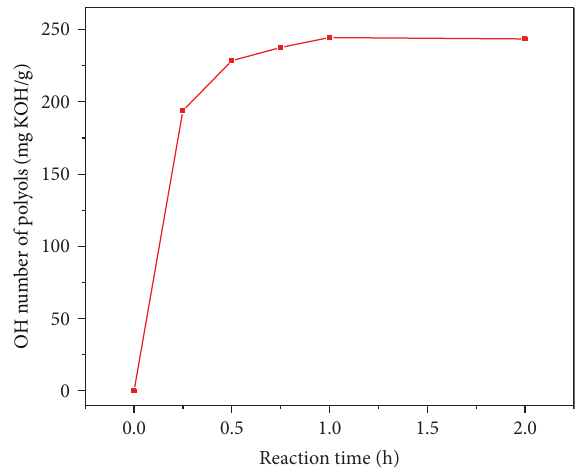
Figure 8: OH numbers of polyols with different reaction time.